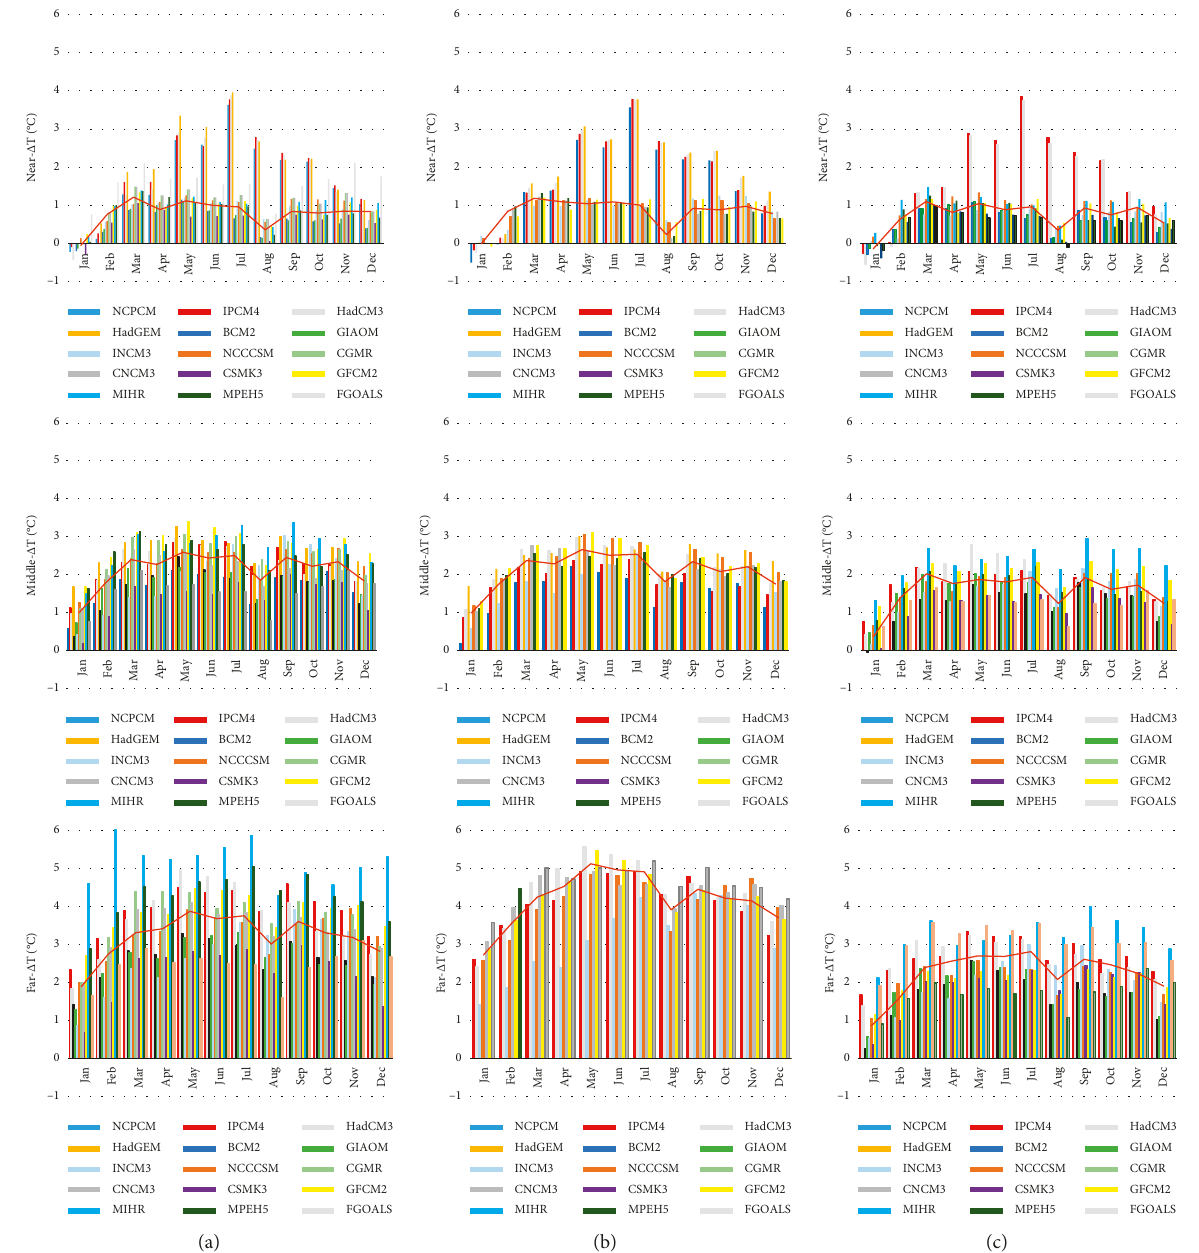
Figure 2: Tmin changes under different GCMs and ensemble approach versus observational values for the three future period under scenarios (a) A1B, (b) A2, and (c)